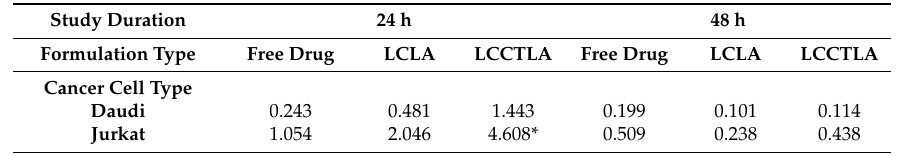
Table 1. IC50 values for the formulation in Daudi and Jurkat cells. Study Duration 24 h 48